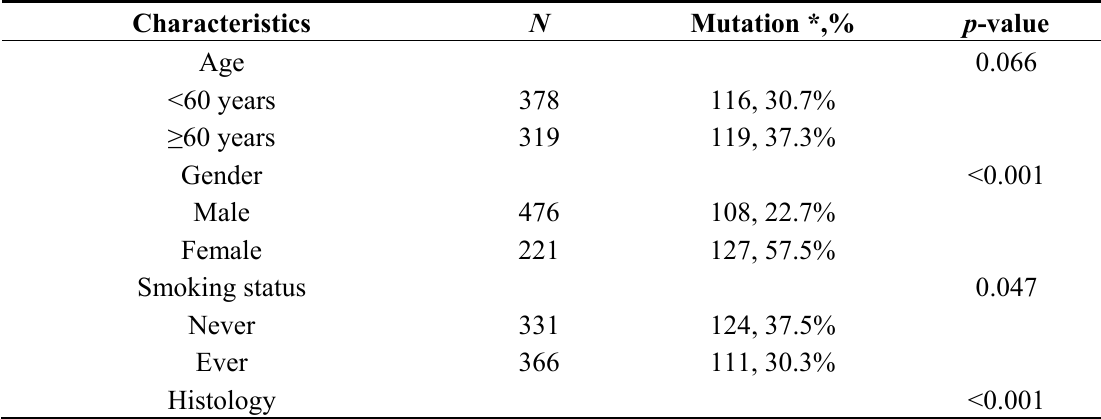
Table 1. Patient